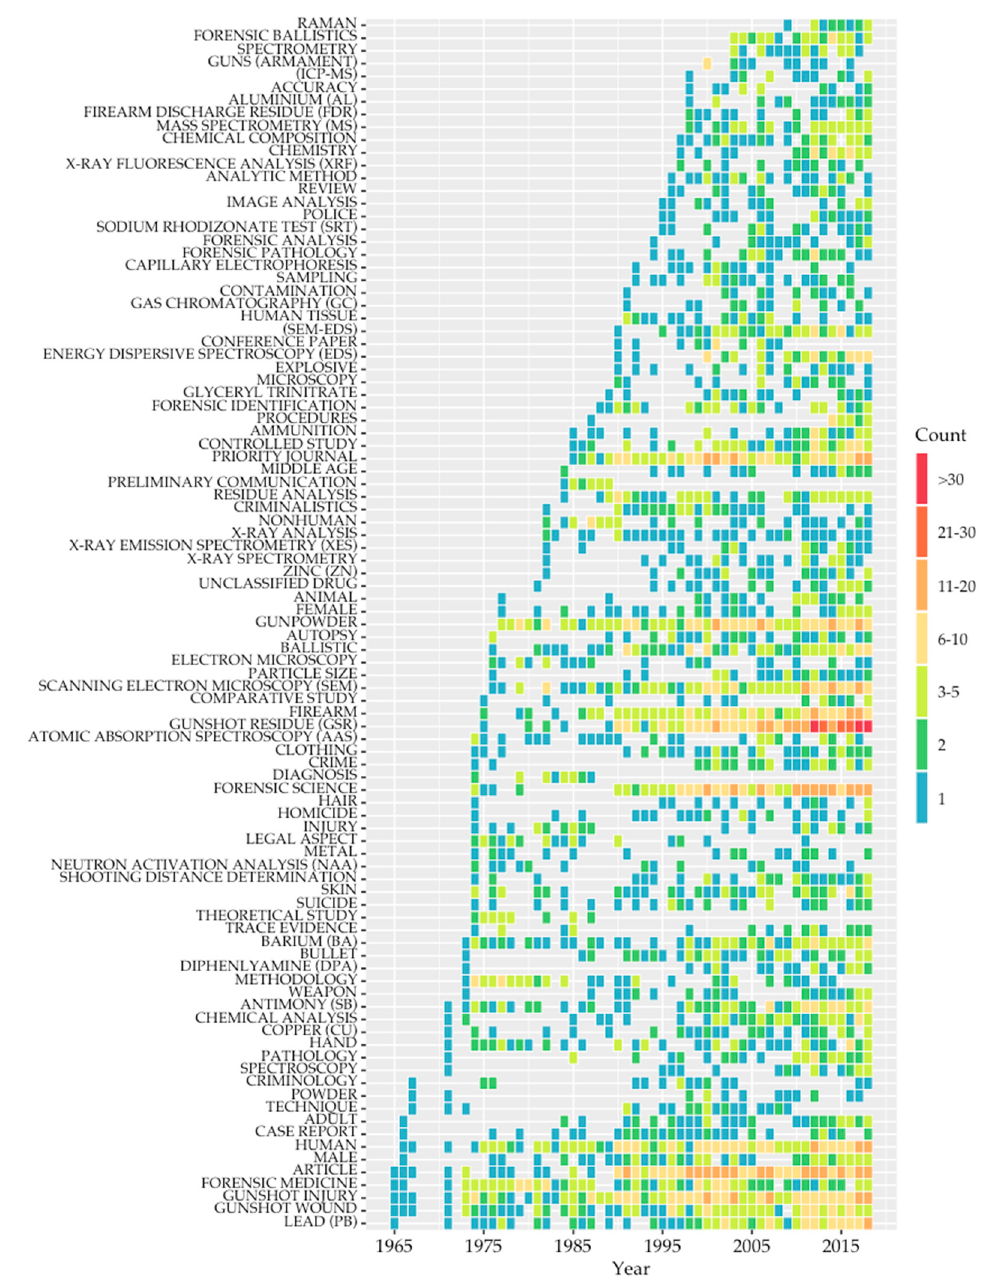
Figure 5. Most commonly found keywords in Scopus search for “gunshot AND residue”. List ordered by first year of appearance.